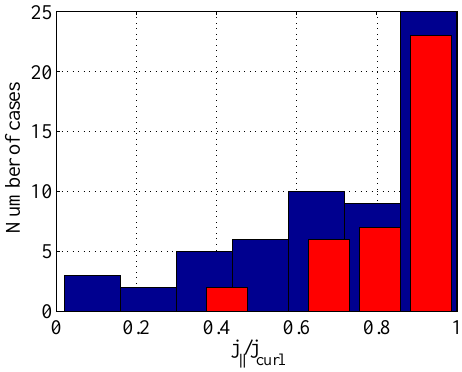
Figure 7. Ratio of currents j (cid:107) parallel to the magnetic field and total currents j (blue for all cases and red only for tilted CSs with | N z | < 0 .